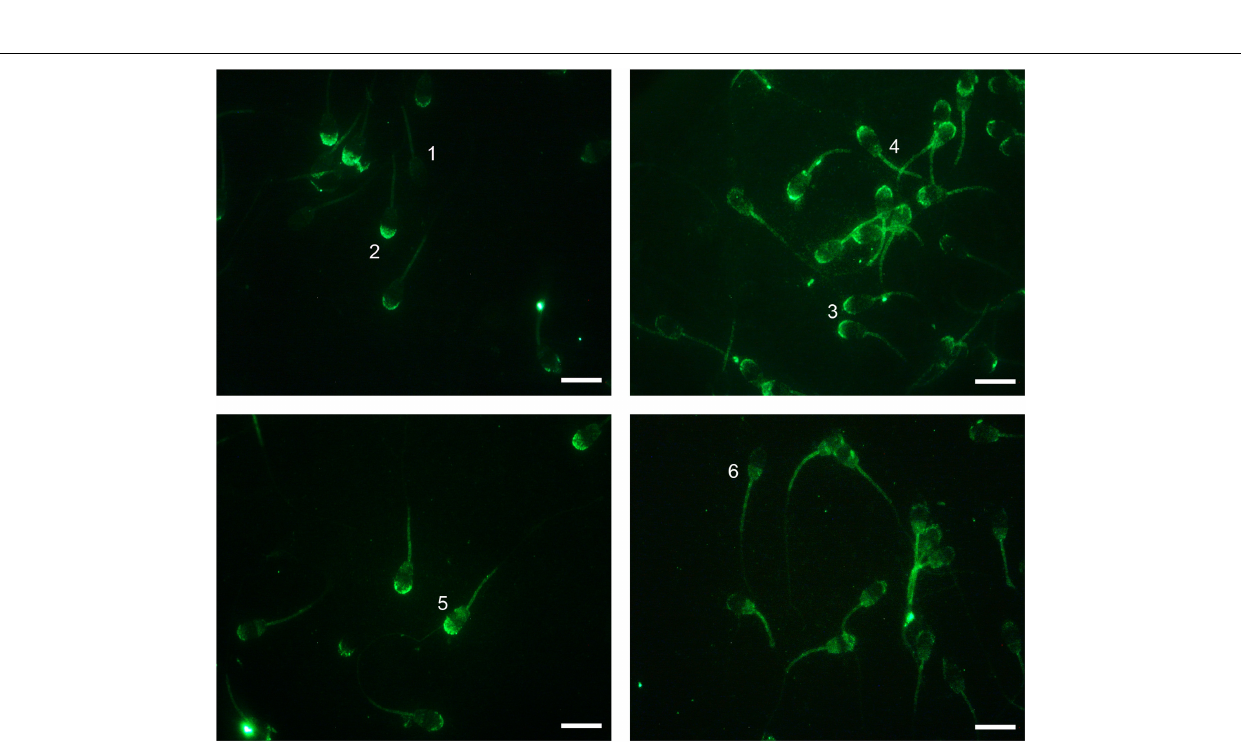
Frontiers in Cell and Developmental Biology |